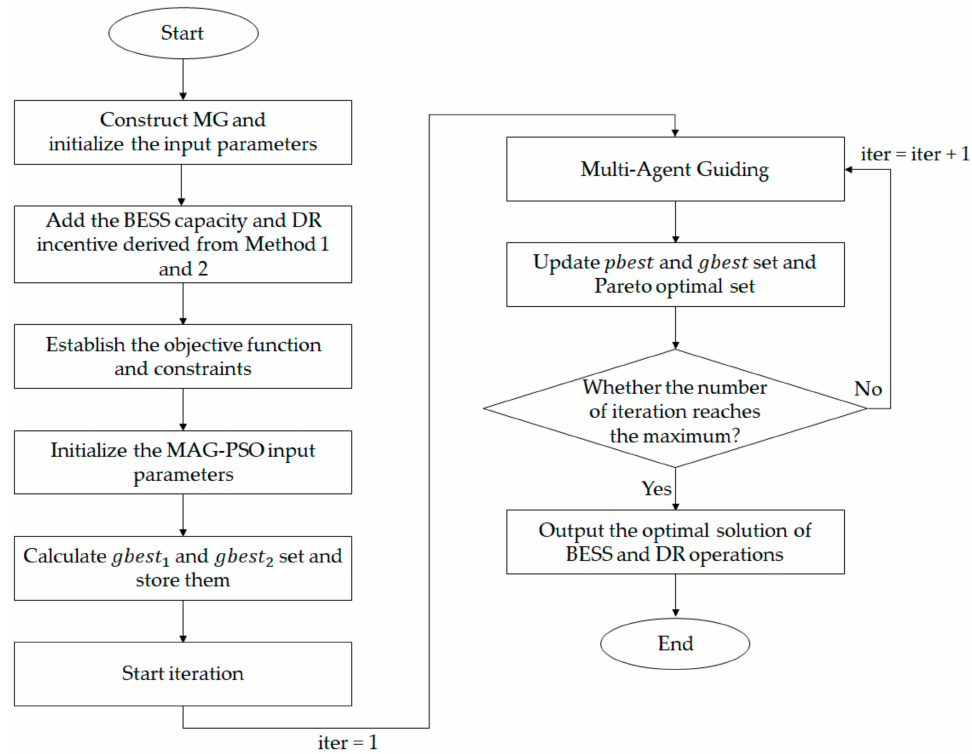
Figure 3. Overall procedure of the proposed optimal hybrid method